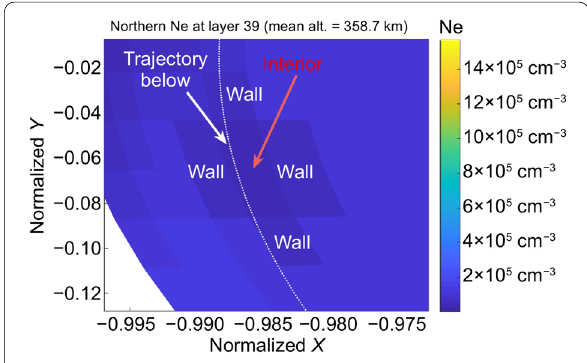
Fig. 17 A gnomonic projection view of LEO SFF trajectory passing the EPB. (Adapted from Peng and Scales